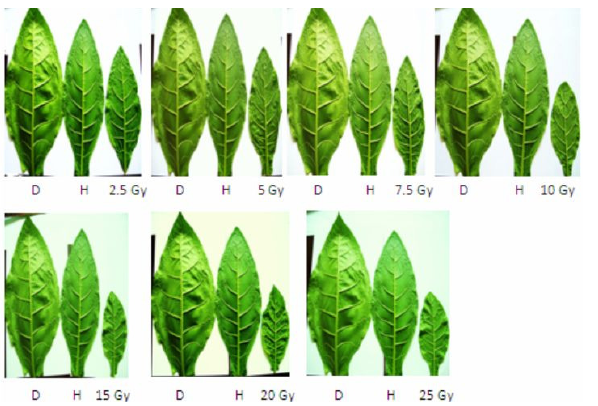
Fig. 6b. The difference between diploid (D), haploid (H) and irradiated haploid leaves